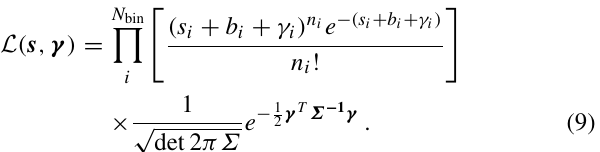
Fig. 3 p T distributions (left) for the three hardest jets in a benchmark model with production of chargino–neutralino pairs with m ˜ χ 0 as well as the corresponding cut-efficiencies